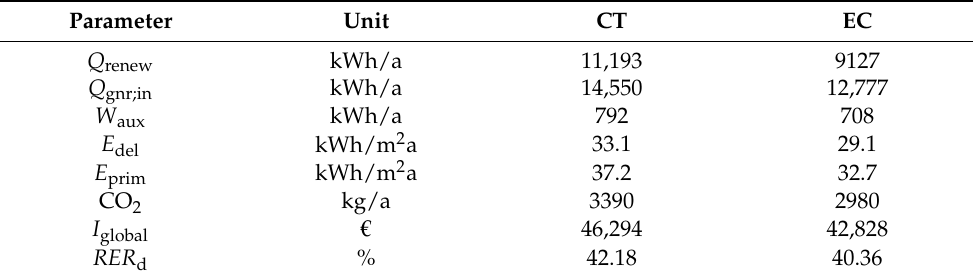
Table 9. Simulation results obtained using CT and